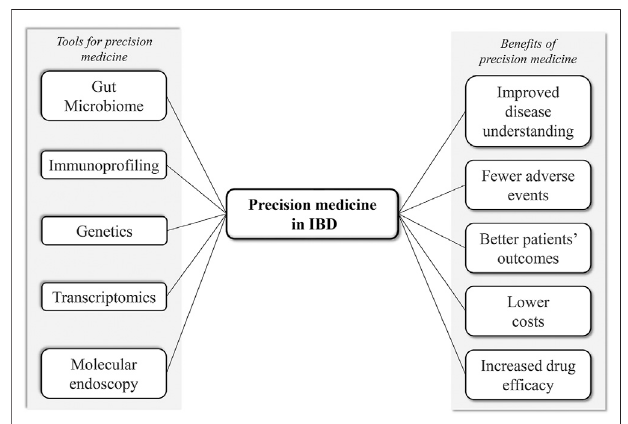
FIGURE 1 | Schematic fi gure summarizing the tools and possible bene fi ts of precision medicine in